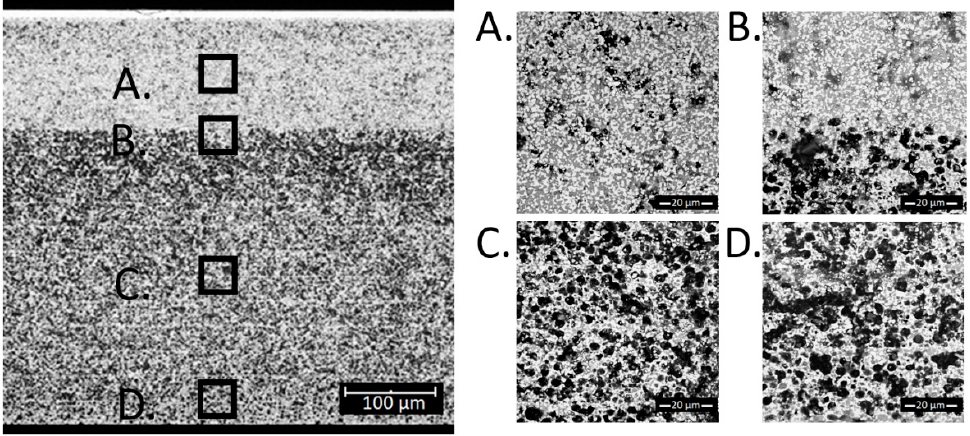
Figure 7. SEM cross-section images of a sample with 36 vol.% NiO obtained using the “slow” method. ( A ) is the region of the functional layer, ( B ) is the interface between the functional and the porous layer, ( C ) is the porous functional layer and ( D ) is close to the outer edge of the cell.